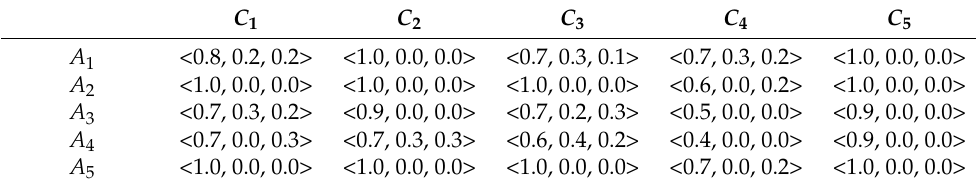
Table 13. The ratings obtained from the second of three respondents.